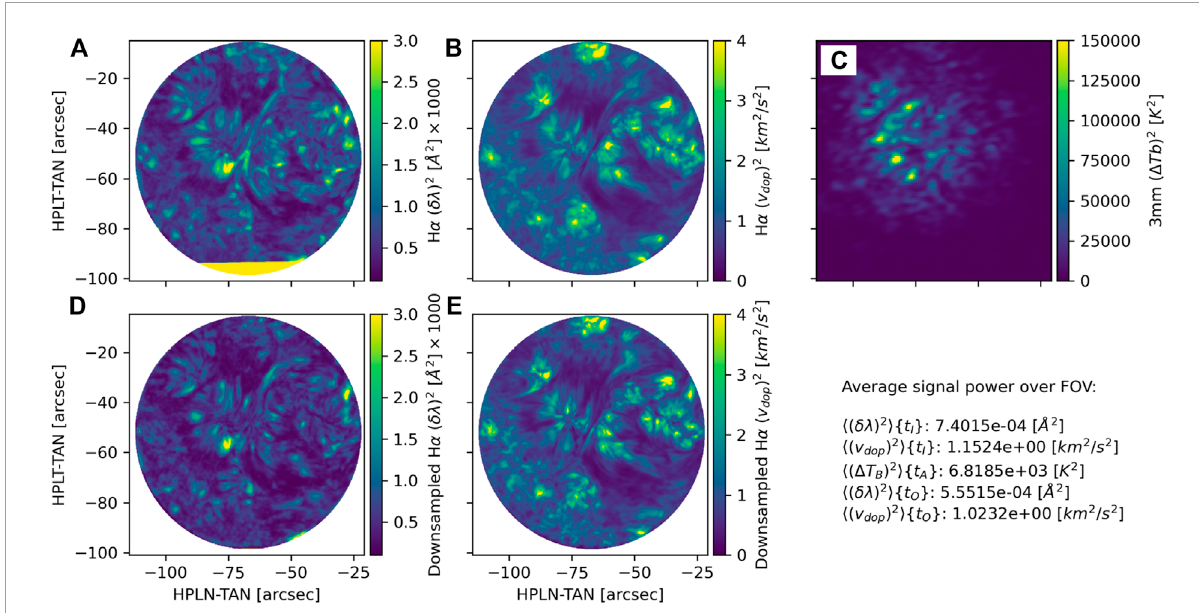
FIGURE 5 Total time-averaged power maps for different data series: (A) δλ , (B) v dop , (C) Δ T B , each calculated over the respective time series { t I } and { t A } . (D) and (E) repeat the first two panels for the IBIS data, but use the down sampled, overlap time series { t O } . The spatially averaged total power is given for each data series in the lower right